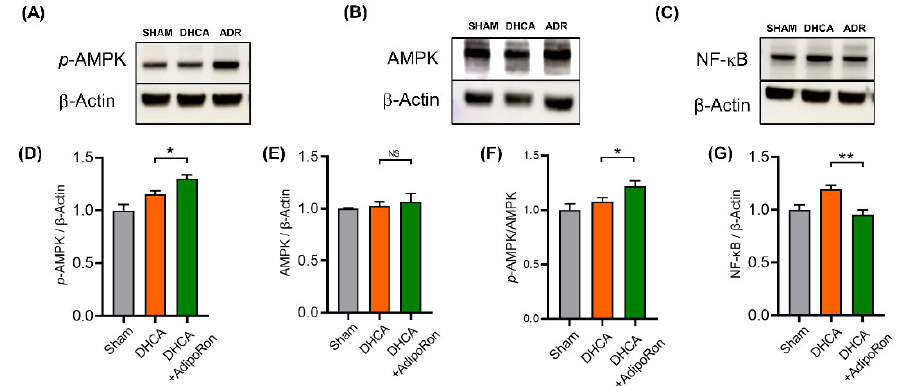
Figure 6. AdipoRon modulates activation of AMPK and downregulates NF- κ B protein in rat hip- pocampus. Expression of ( A ) phosphorylation status of AMP-activated protein kinase (p-AMPK; molecular weight: 62 kDa), ( B ) AMPK-activated protein kinase (AMPK; molecular weight: 62 kDa), ( C ) nuclear factor κ B (NF- κ B; molecular weight: 65 kDa) in rat hippocampus of AdipoRon- and vehicle treated rats was measured by immunoblot. An amount of 30 µ g protein of each sample was used for gel electrophoresis. Column bars indicated quantified levels of target protein/Actin expression ratios ( D – G ), and the results are relative values whereby the expression level of the sham control was normalized to 1.0. n = 6 in each group. Results are presented as the mean ± SEM. Student’s t test was used to compare the differences between the DHCA group and the AdipoRon-treated DHCA group. * p < 0.05 and ** p < 0.01 . NS: p >